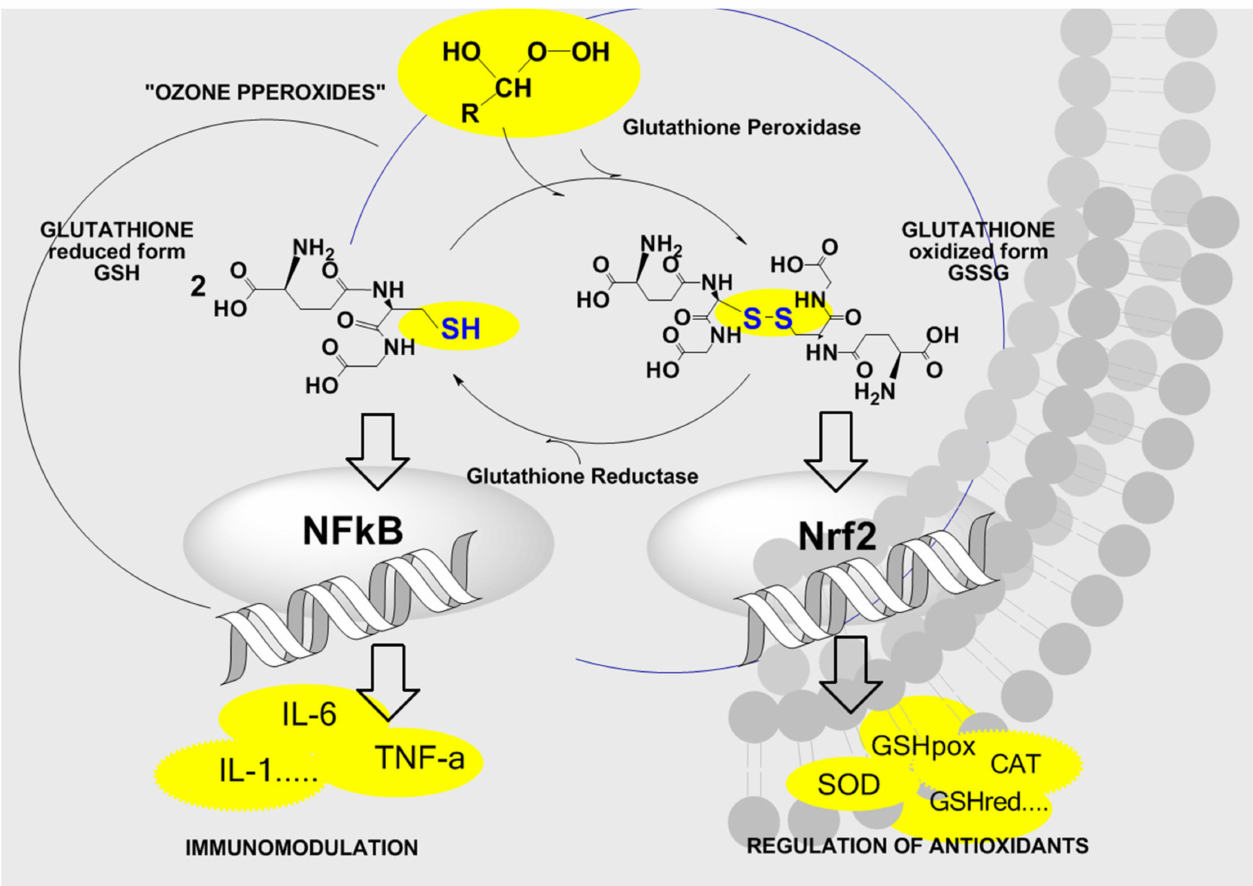
Figure 7. Pharmacological effects of ozone: signal transduction via glutathione and “ozone peroxides”. An intact GSH/GSSG balance is the limiting factor for the ozone concentration and the basis for the low-dose ozone concep revision from